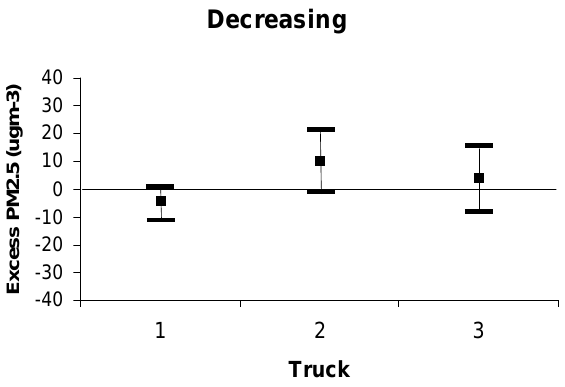
Figure 9. Ensemble average Daysmoke minus observed PM for the three days when smoke concentrations decreased with distance. The spreads of the departures are shown by the horizontal